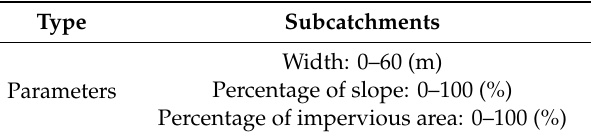
Figure 7. Calibration and validation data. Table 1. Calibration